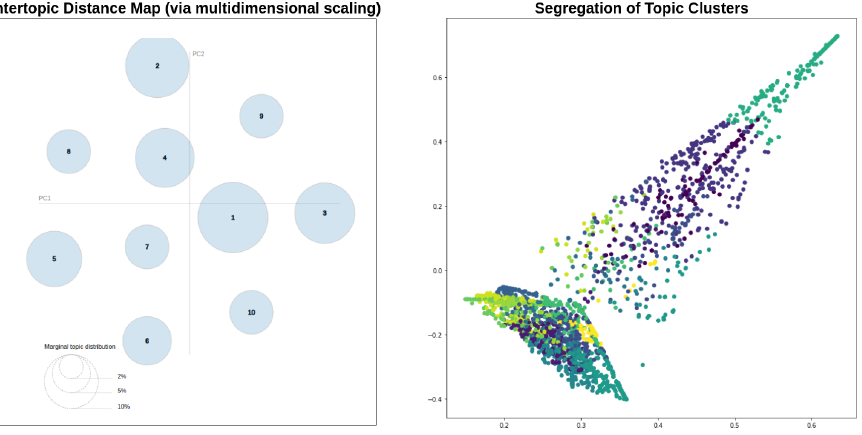
Figure 2. On the left, the intertopic distance map; each bubble represents a single topic, and the bubble size represents prevalence. On the right, the segregation of topics into clusters; each point color represents the topic